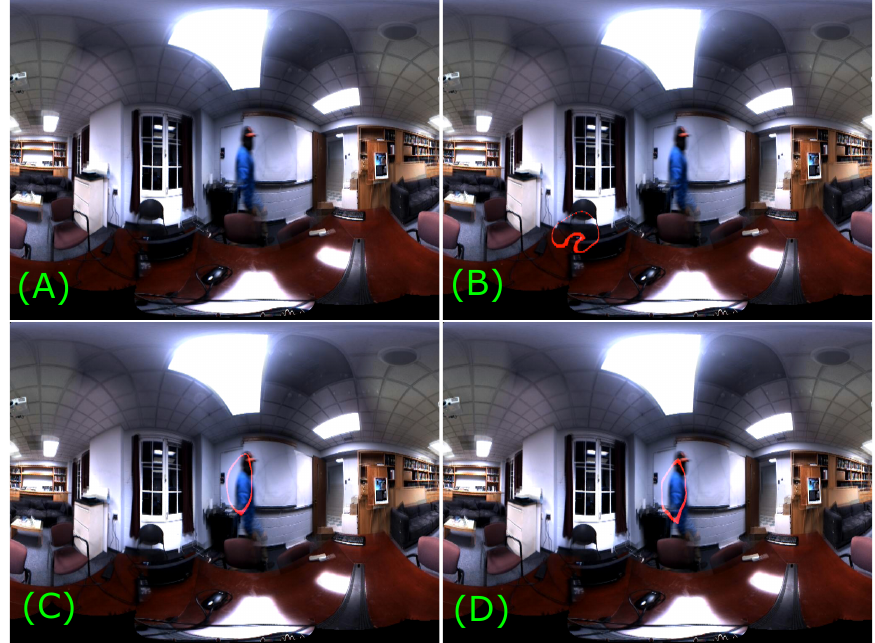
Figure 10. Comparison of AVSM with unisensory saliency maps. ( A ) Input Frame #50 of Dataset 4. The most prominent event in the scene is the person moving. ( B ) The most salient location according to ASM misses the most salient location, but shows a different location as salient. ( C ) VSM shows the prominent motion event as salient as expected. ( D ) AVSM 1 also captures the salient motion event as the most